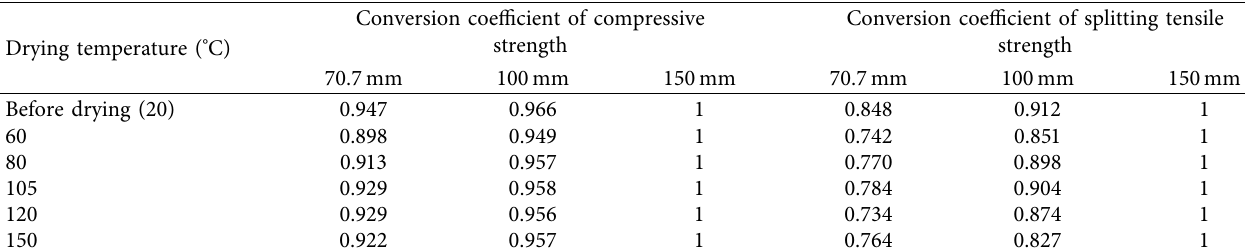
Table 4: Conversion coefficients of strength with different temperatures and